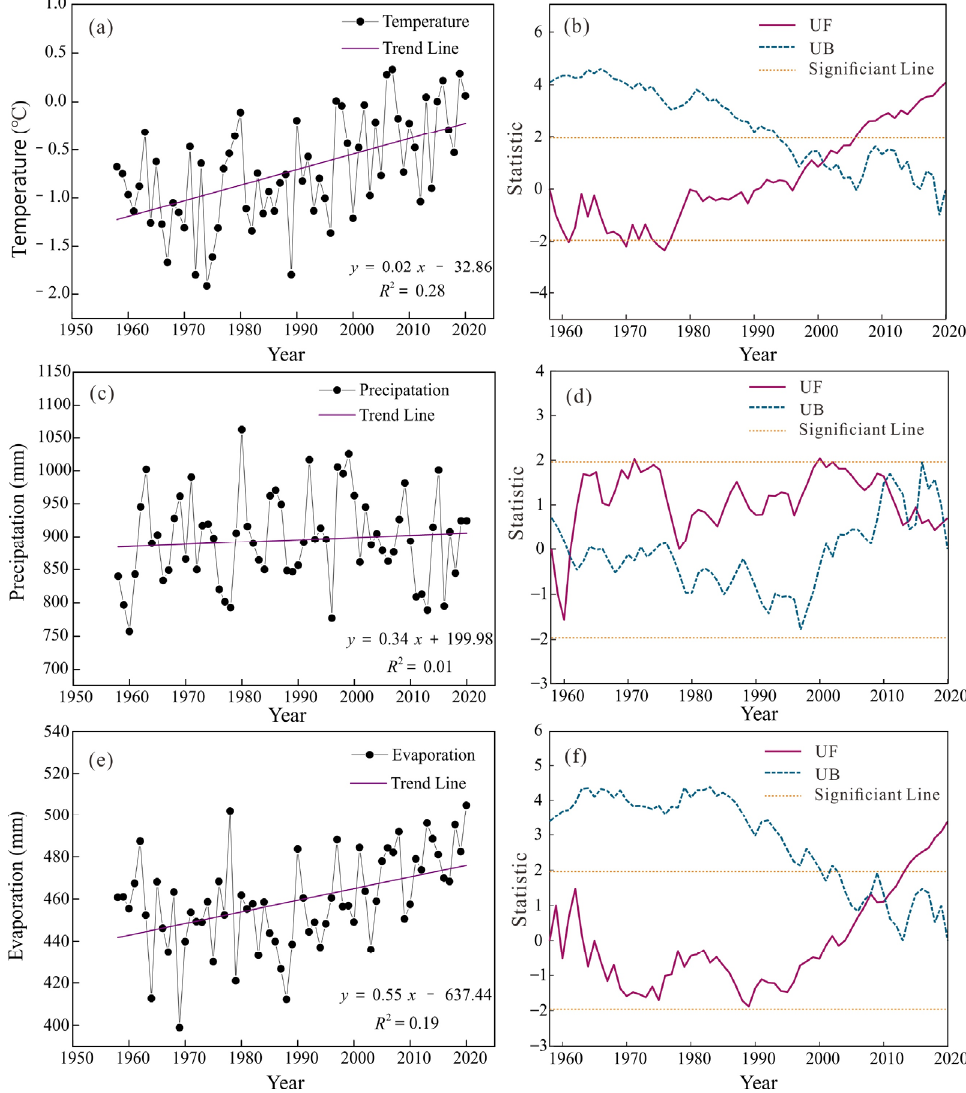
Figure 11. Inter-annual variations in ( a ) the annual mean temperature, ( c ) the annual total precipitation, and ( e ) the annual total evaporation of the Issyk-Kul Lake Basin, and ( b ) the M–K tests of ( b ) temperature, ( d ) precipitation, and ( f ) evaporation.